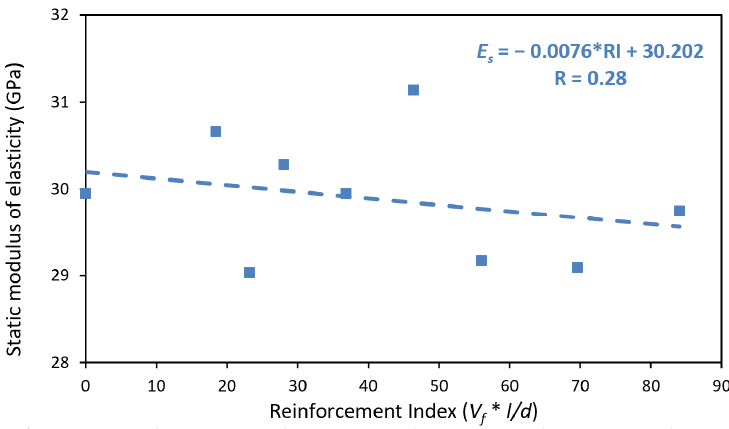
Figure 8. Correlation between the Reinforcement Index and the Static Elasticity Modulus.